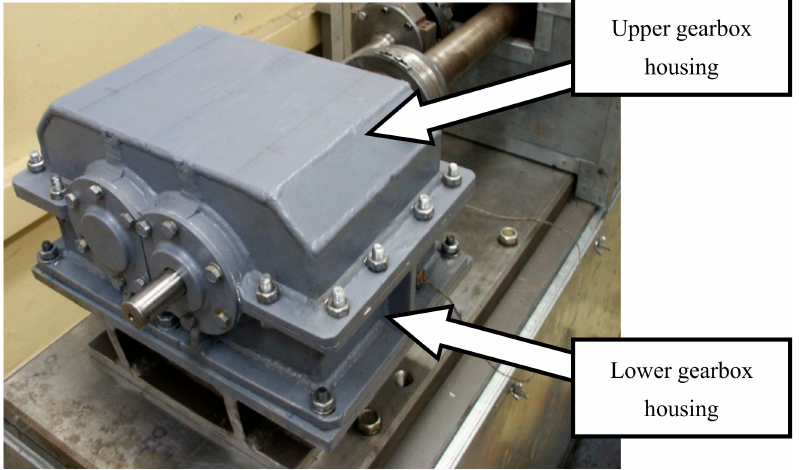
Figure 1. View of the gearbox tested on the FZG power circulating